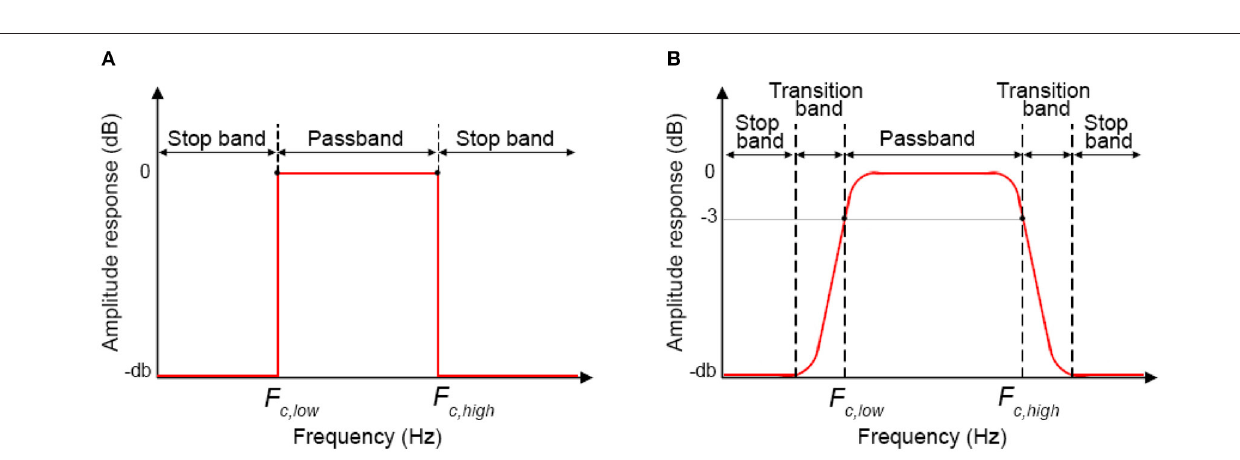
FIGURE 10 | Filter amplitude response for ideal filters (A) and real filters (B)